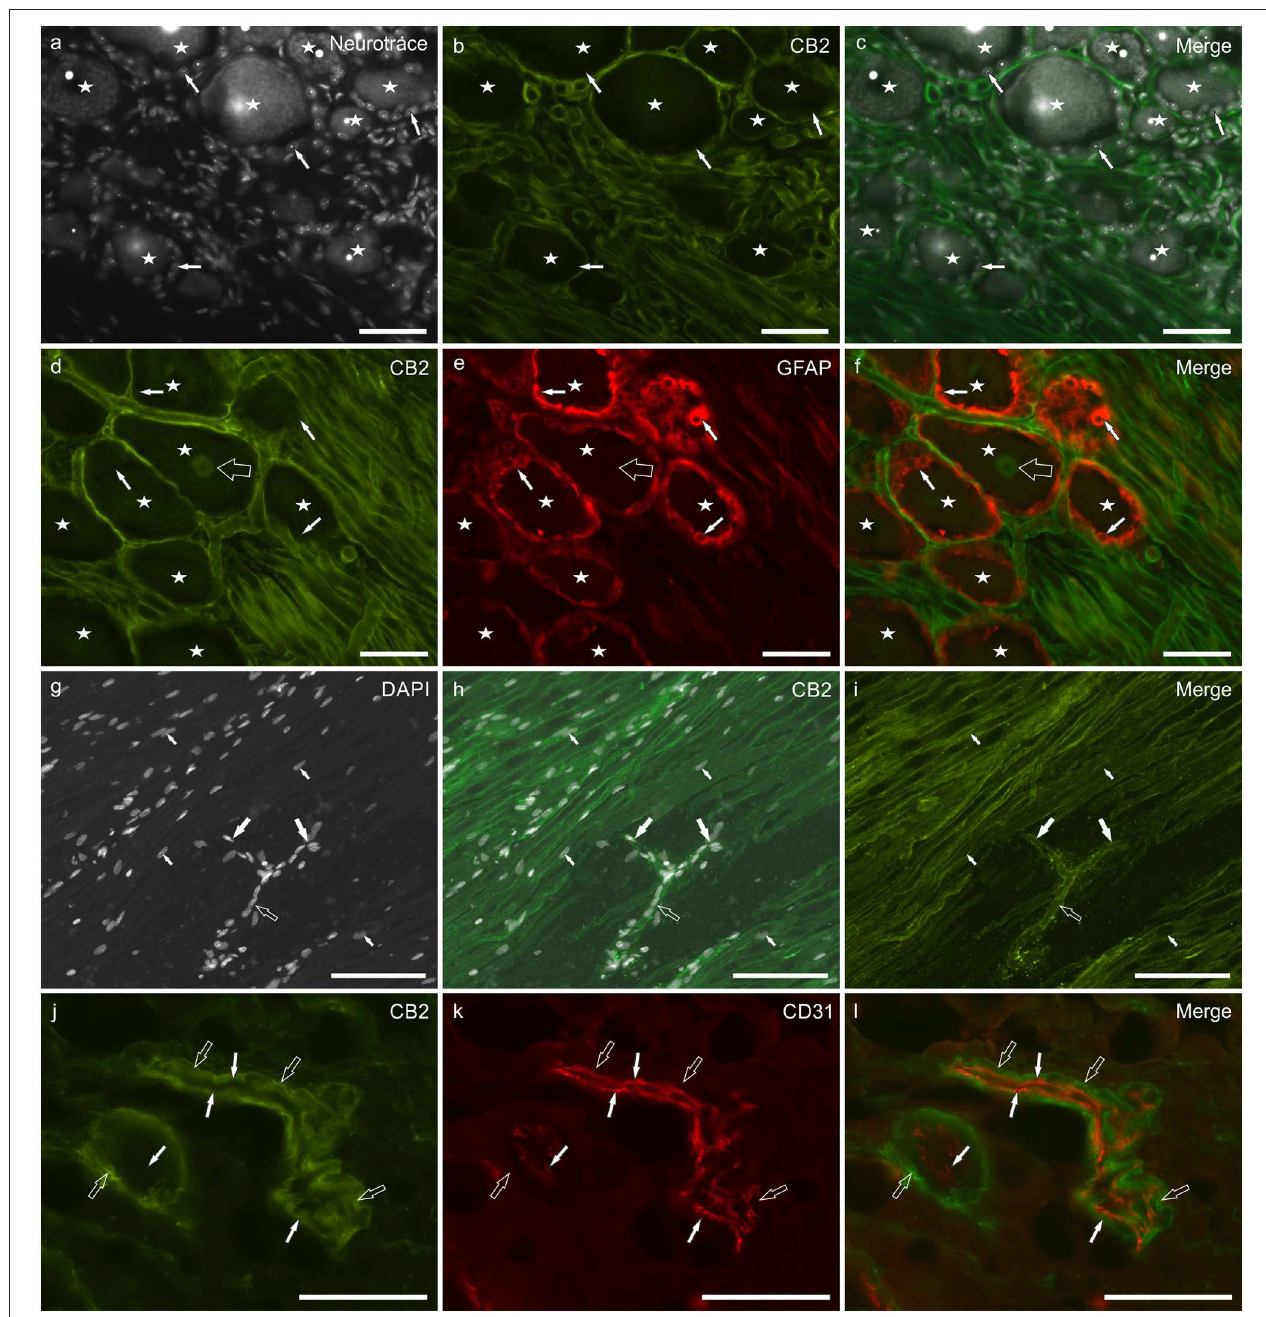
FIGURE 3 | Photomicrographs of cryosections of canine cervical (C8) dorsal root ganglion showing cannabinoid receptor 2- (CB 2 ), glial fibrillary acidic protein- (GFAP), and CD31-immunoreactivity. (a–c) Stars indicate NeuroTrace labeled (a) dorsal root ganglion sensory neurons which were CB 2 receptor negative (b) , as well as the satellite glial cells (white arrows). (d–f) Stars indicate sensory neurons encircled by satellite glial cells (white arrows) which were GFAP-immunoreactive (e) and CB 2 receptor negative. CB 2 receptor immunoreactivity was expressed by Schwann cells and neuronal nuclei (open arrow). (g–i) The empty arrow indicates one neuronal axon that bifurcates (T-junction) in its central and peripheral portions (large white arrows). The small arrows indicate the nuclei of Schwann cells. (j–l) Open arrows indicate smooth muscle cells (vessel on the left) and pericyte-like cells (elongated and thin blood vessel on the right) showing CB 2 receptor immunoreactivity (j) . White arrows indicate endothelial cells showing CD31 immunoreactivity (k) . Bar: a–f, j–l = 50 µ m; g–i = 100 µ m. is possible to state with some confidence that, in the rat medium-and large-sized cells in rat DRG to predominantly DRG, CB1 receptor immunoreactivity was expressed also by express CB 1 receptor mRNA. Although, in the present large-sized study, the area of DRG neurons was not measured, it